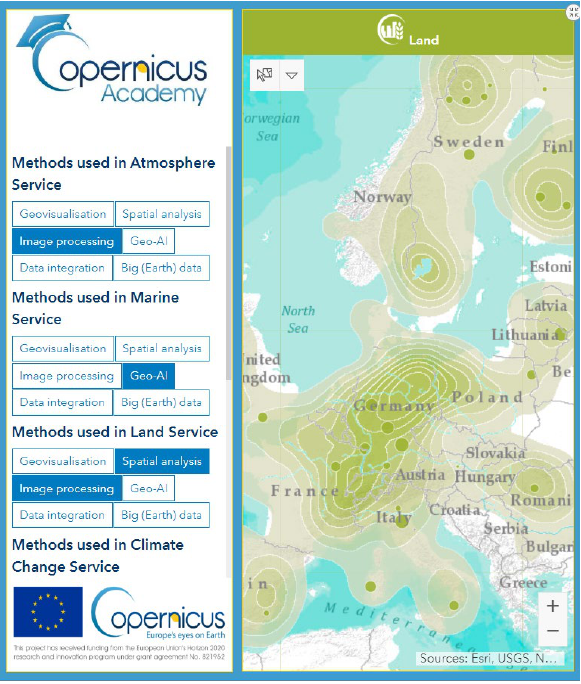
Figure 4. Knowledge Landscape (note that currently synthetic data are used for testing purposes) 2.1.3 Innovation Monitor: In order to represent